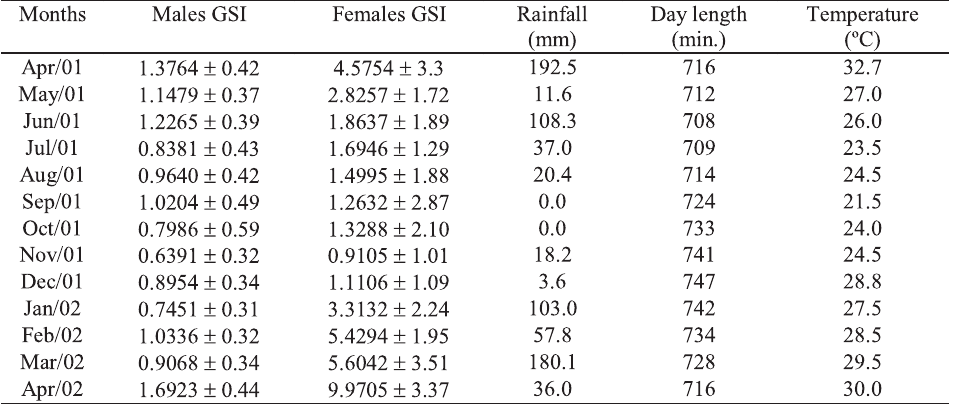
Table 1 . Abiotic data (rainfall, day length and temperature) and monthly variation of the means of the gonadosomatic index (GSI) ( ± standard deviation) for males and females of Serrapinnus piaba , collected in the rio Ceará Mirim, from April 2001 to April